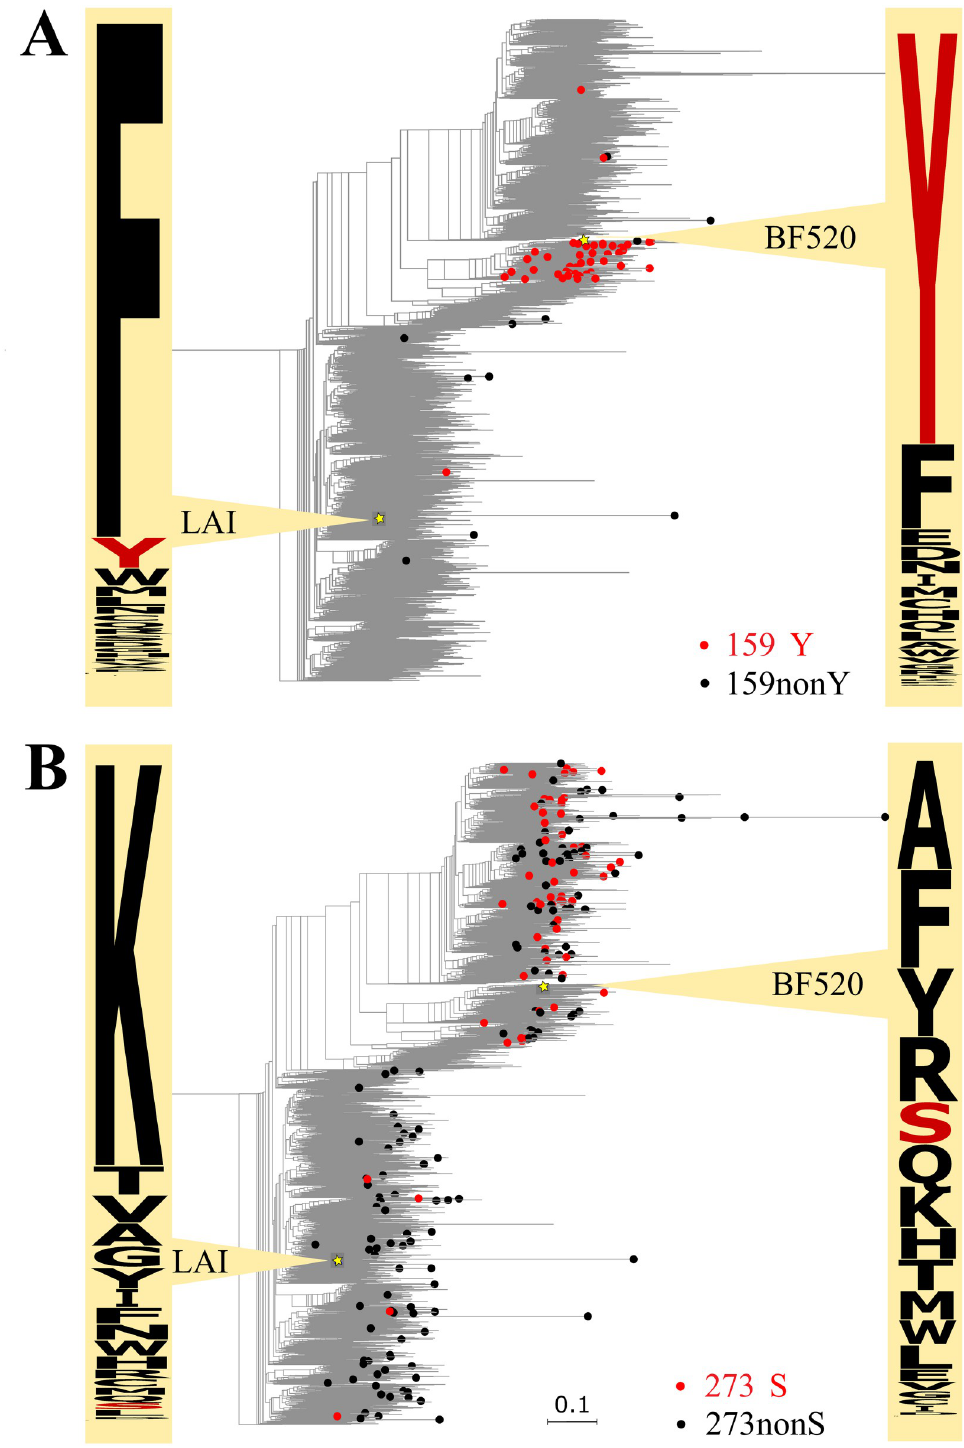
Fig 5. Substitutions to variable fitness amino acids (red) and to other amino acids (black) at sites 159 (A) and 273 (B) of gp-160, and amino acid propensities in DMS experiments in strains BF520 and LAI. Phylogenetic distances are in numbers of amino acid substitutions per site. Numbering of protein positions is hxb2-based. Logos of experimentally derived amino acid propensities were built with Weblogo (https://weblogo.berkeley.edu/logo.cgi).